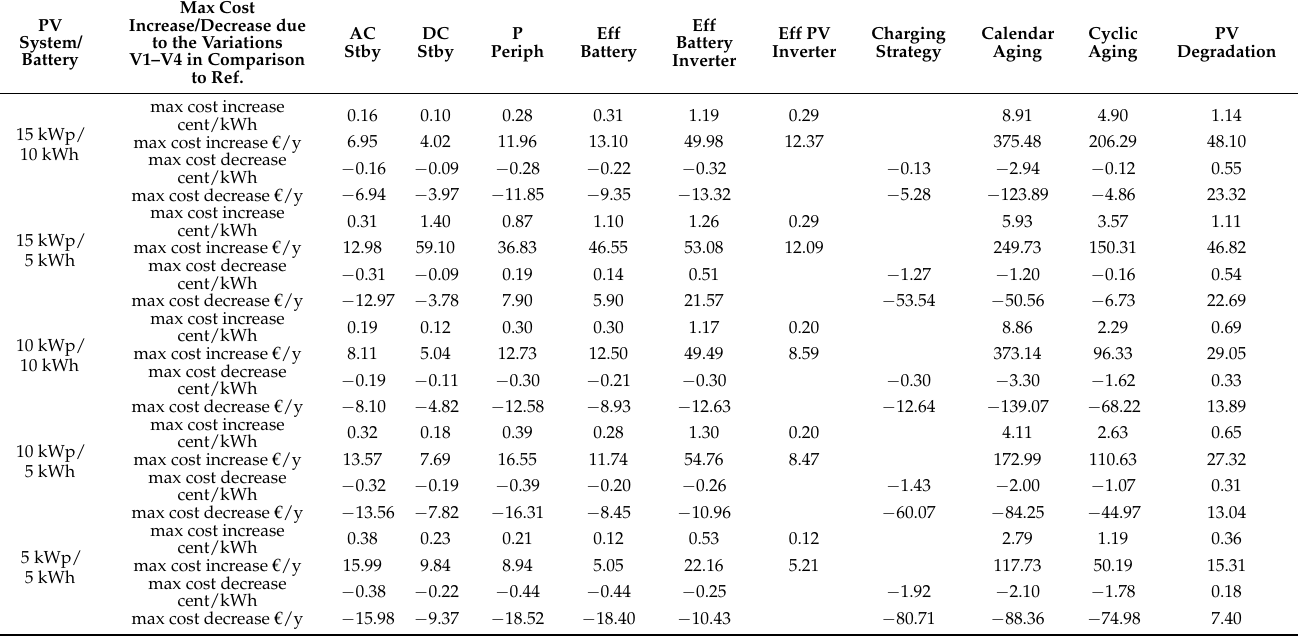
Table A6. Overview of the maximum changes regarding electricity cost through V1 to V4 of the individual technical parameters compared to the reference case. To calculate the total cost for the calculation period the maximum cost increase and decrease needs to be multiplied by